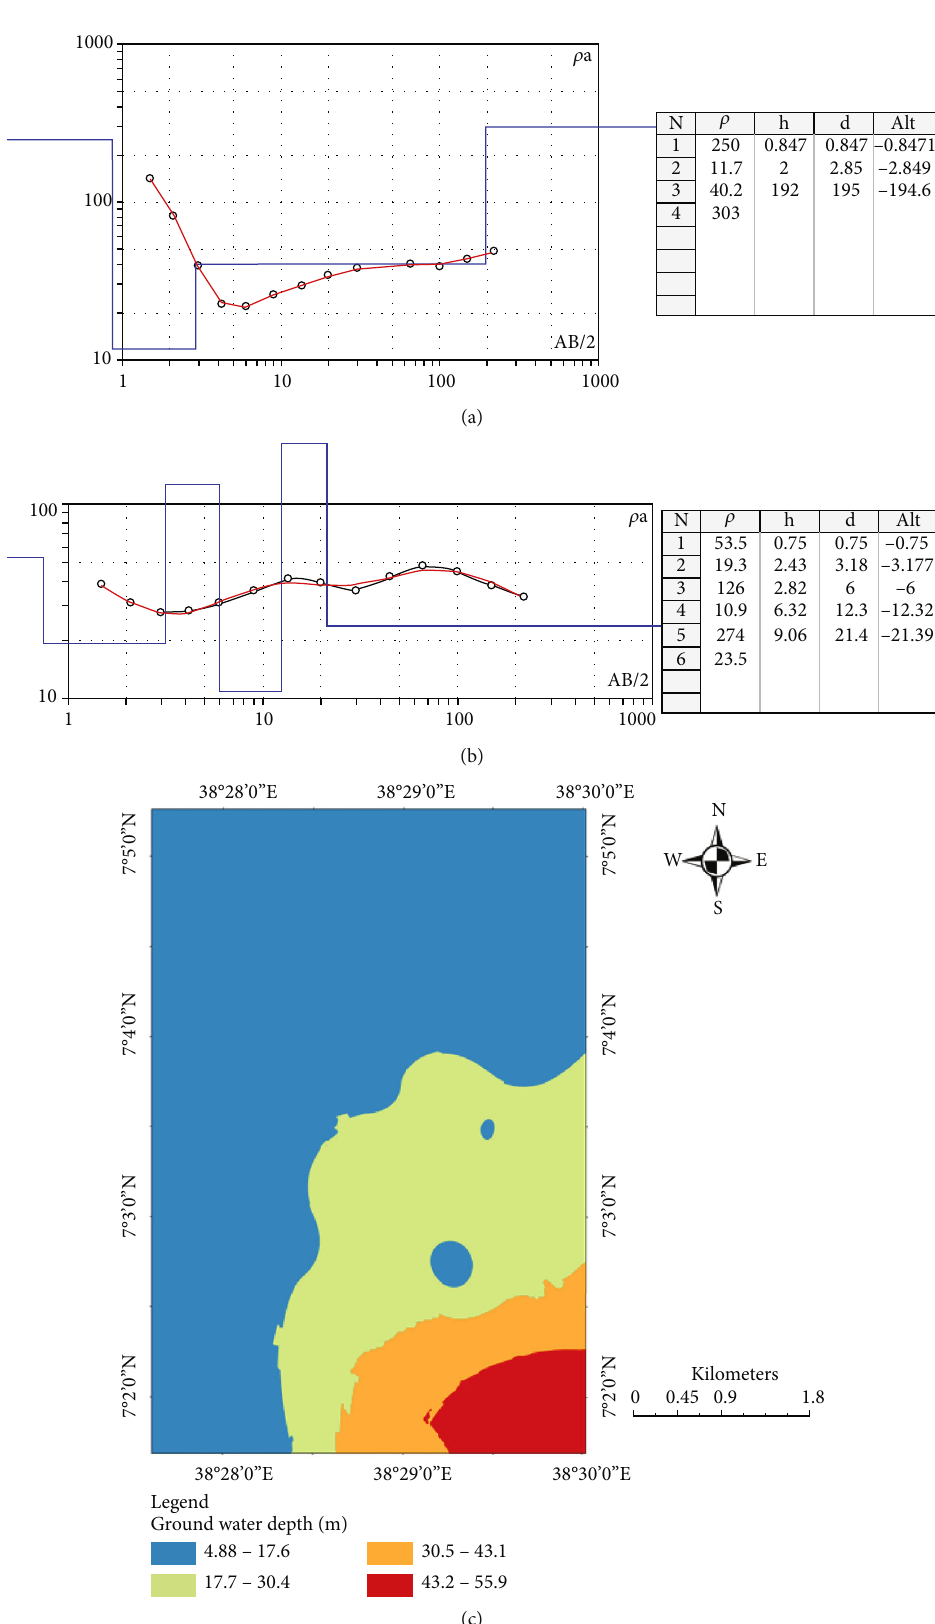
Figure 5: (a) VES1 inverted ρ graph, (b) VES2 inverted ρ graph, and (c) groundwater level map from the borehole in Hawassa